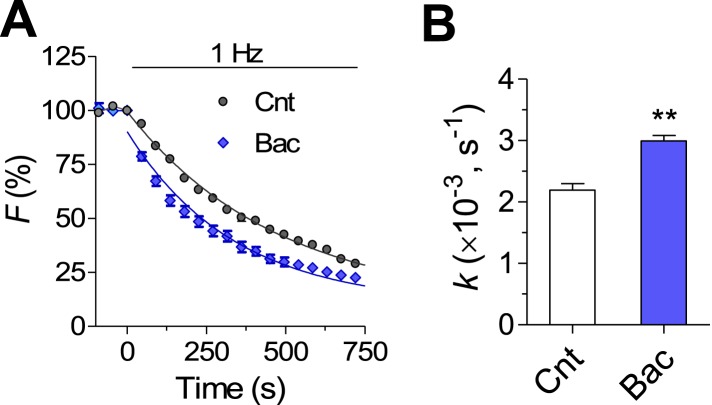
Synaptic vesicle exocytosis evoked by 1 Hz stimulation is increased after 2 days baclofen incubation.(A) FM1-43 destaining rate curves of 50 synapses under control and 2 days after 10 μM baclofen application. (B) Averaged destaining rate constants in control (n = 5) and in cultures pretreated for 2 days with baclofen (n = 6).